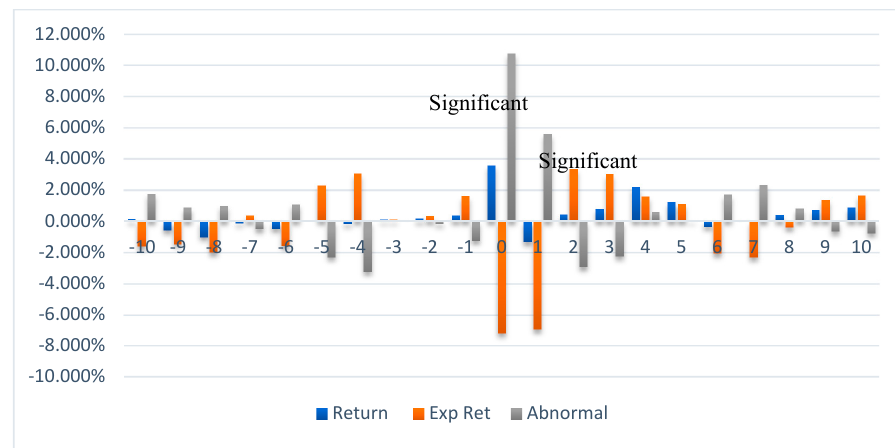
Int. J. Financial Stud. 2018 , 6 , x FOR PEER REVIEW